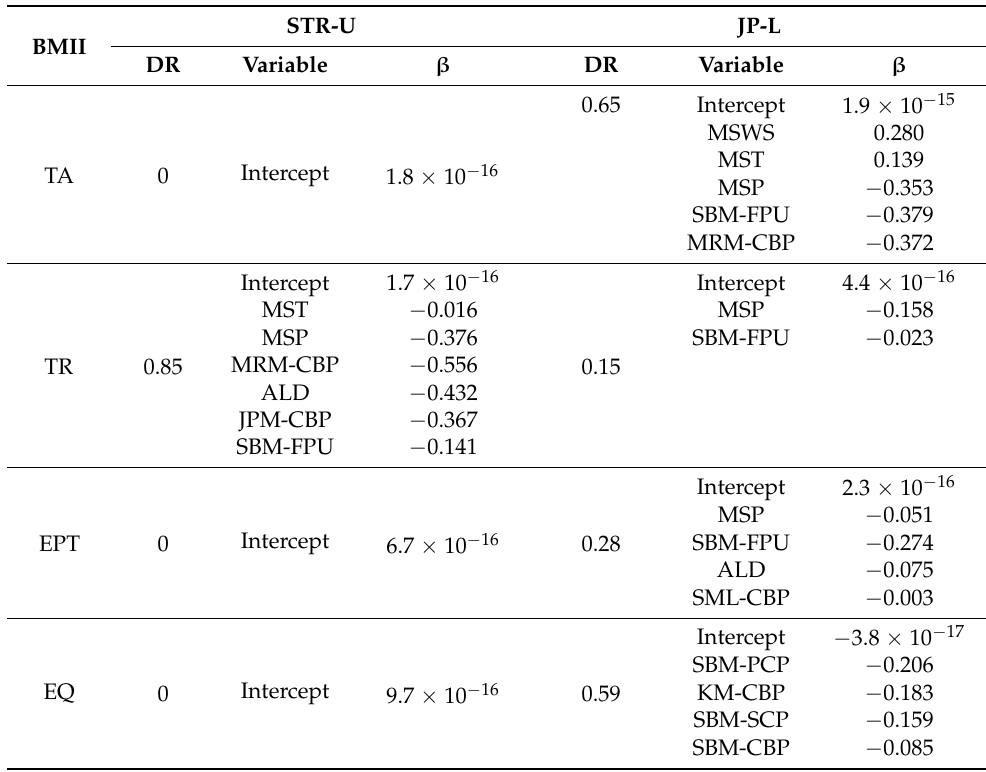
Table 3. Variables selected for the secondary stream sites (STR-U, JP-L) for benthic macroinvertebrate indices (BMII; TA = total abundance; TR = taxon richness; EPT = percent EPT; EQ = equitability), including deviance ratio (DR) and coefficient magnitude; climatic variables selected shown in italics; variable codes defined caption of Table 1. STR-U BMII